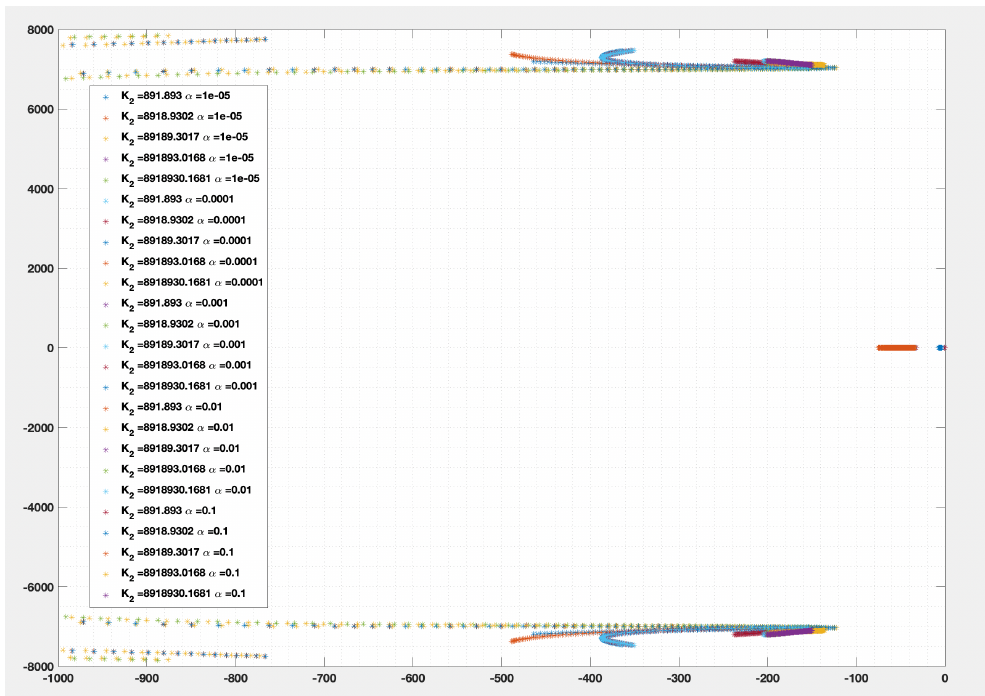
Figure 6. The evolution of the dominant eigenvalues of the Jacobian of the inner closed-loop system considering 100 experimental forced-equilibrium points which correspond to an input signal from the closed ball B ( u = 0.5, ε = 0.1 ) for the sub-optimal values α (cid:63) = 1 × 10 − 3 and K (cid:63) with 24 other experiments where these parameters vary by two decades on the left and right